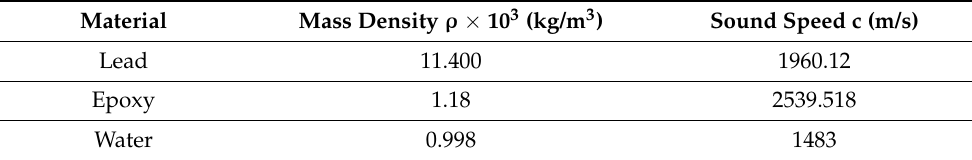
Figure 1. A schematic diagram of a defective 1D PnC structure designed from lead and epoxy with a defect layer filled with fresh water contaminated with cadmium bromide ions. Table 1. Densities and speeds of the suggested materials’